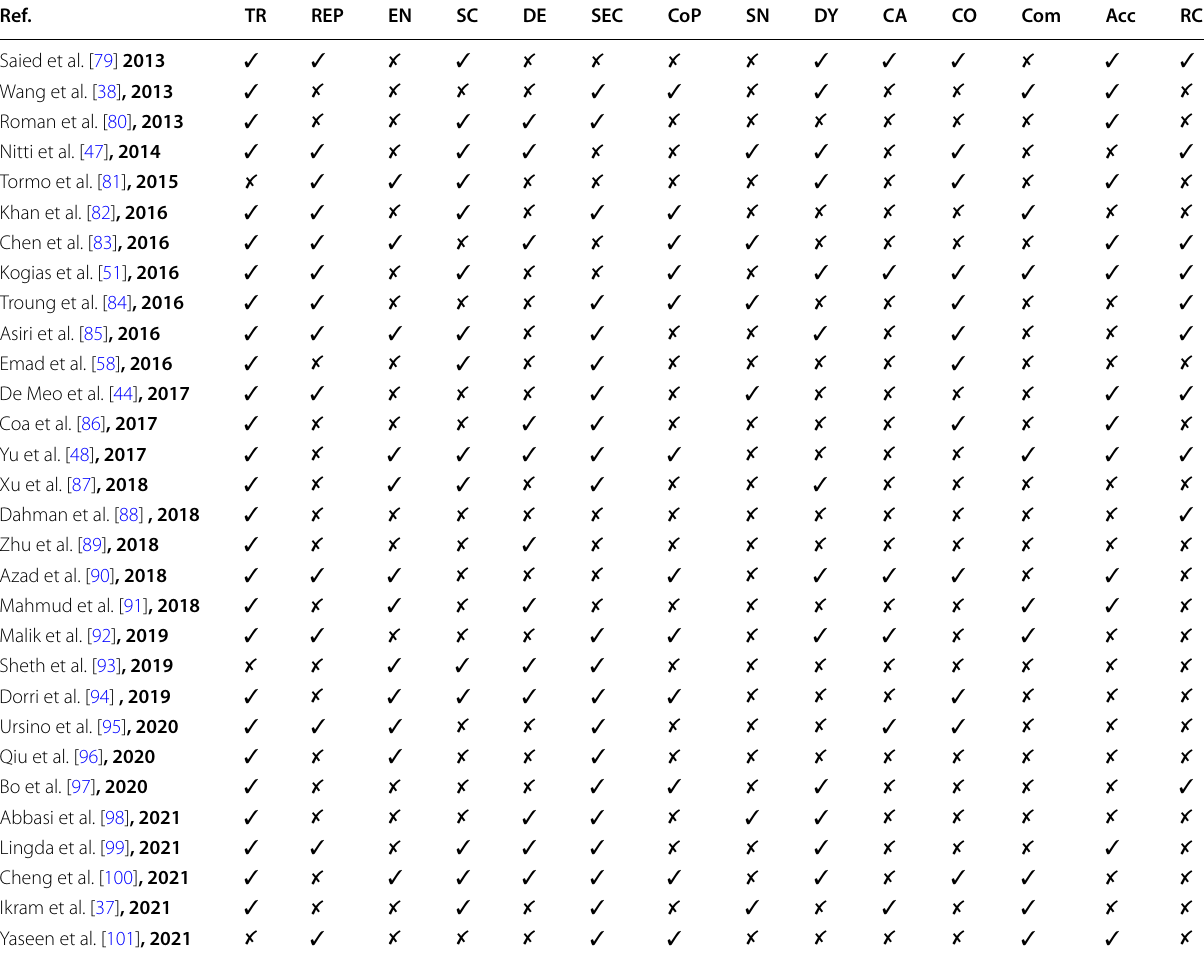
Table 3 Comparative Analysis of Trust-Based Models